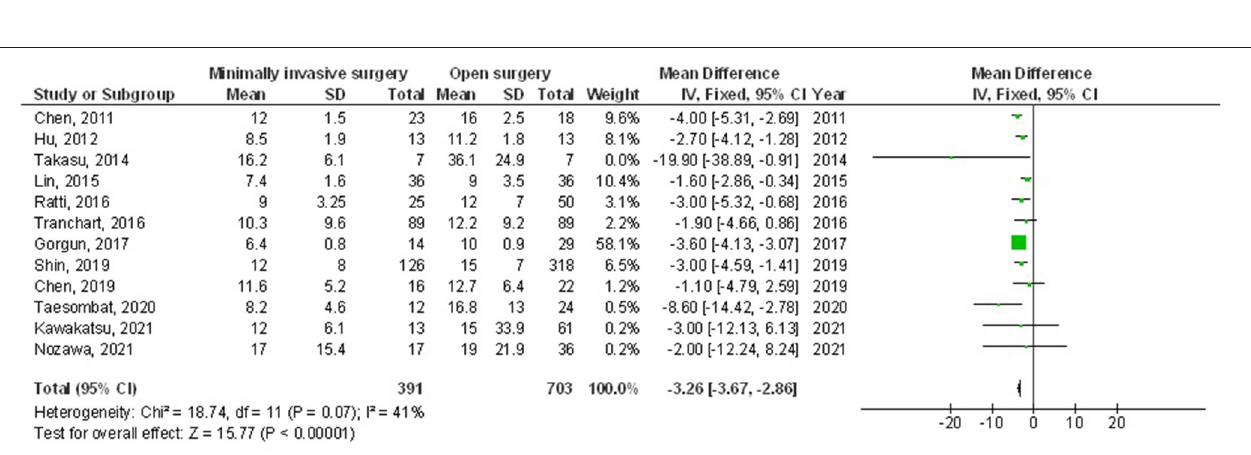
FIGURE 5 | Forest plot of the effect of minimally invasive surgery compared to open surgery on the length of hospital stay in subjects with colorectal cancer and synchronous colorectal liver metastases.